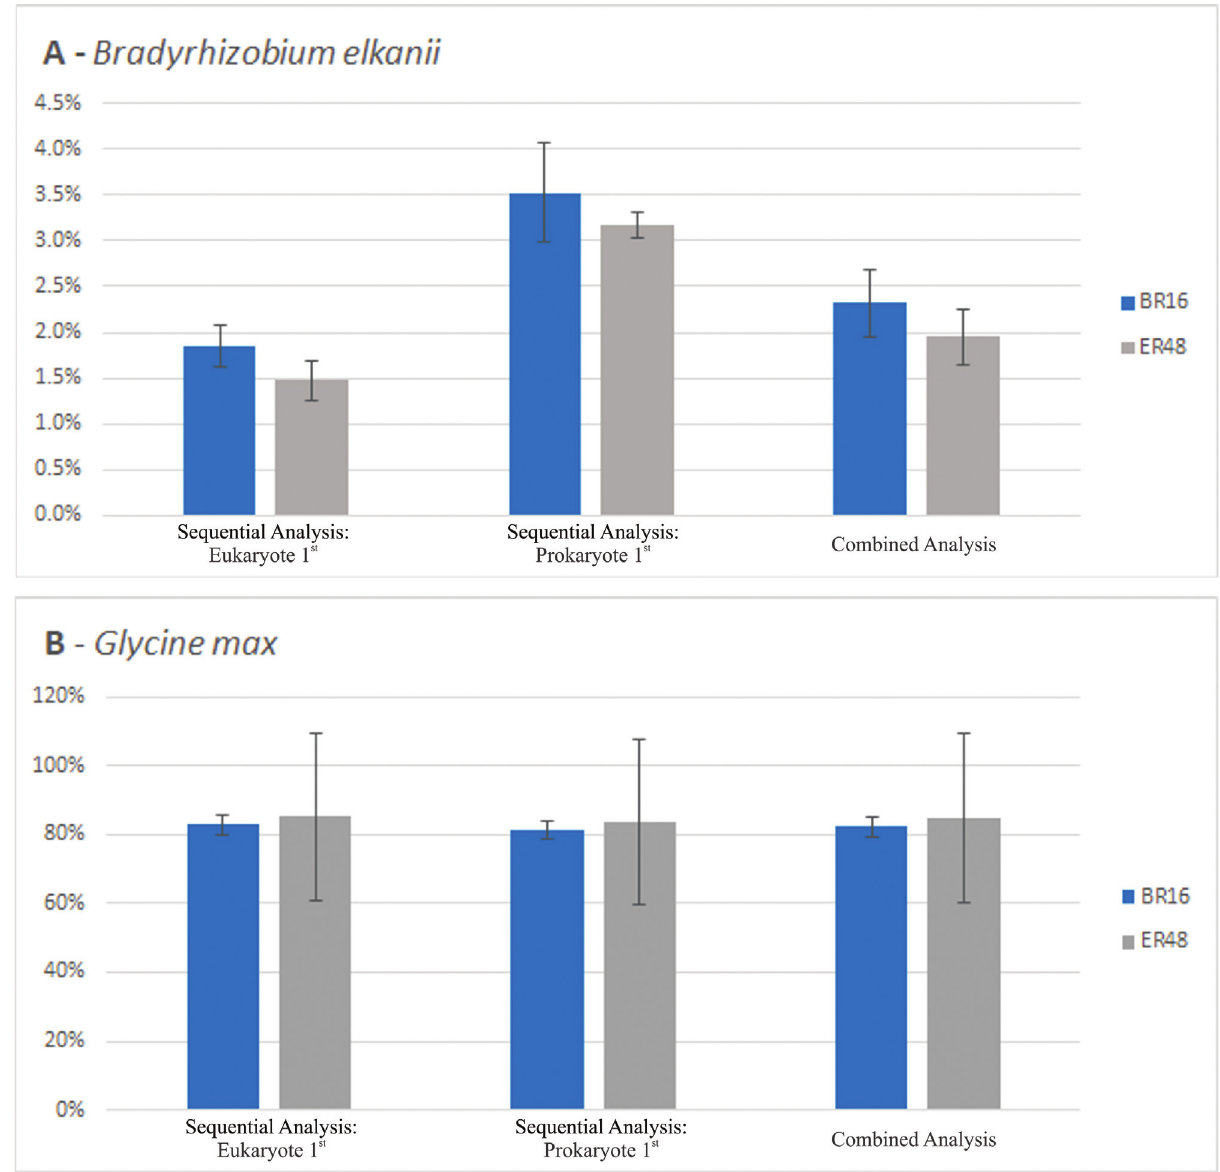
Figure 2 - Percentage of reads mapped to (A) Bradyrhizobium elkanii or (B) Glycine max depending on the methodology used in the Glycine max – Bradyrhizobium elkanii experiment. Bars indicate twice the Standard Error. BR16 and ER48: soybean varieties BR16 and Embrapa 48,